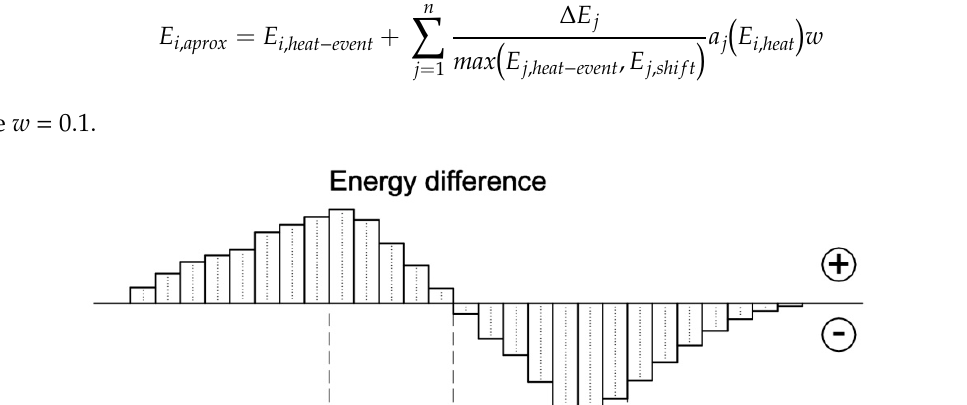
Figure 10. Energy difference between the energy distribution graph and the shifted energy distribution graph.